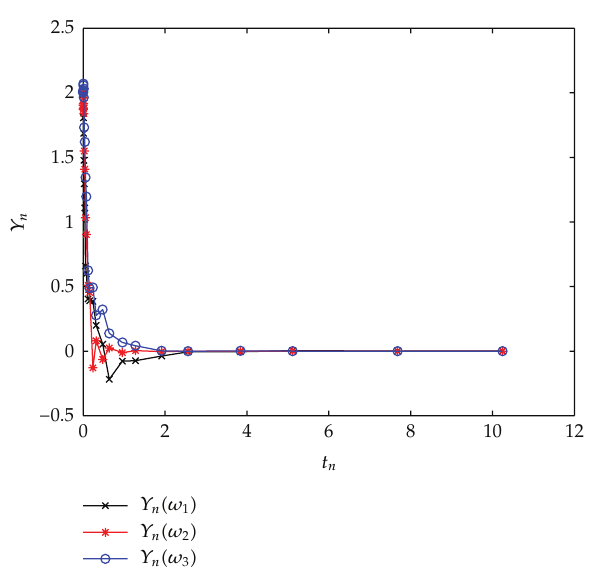
Figure 1: Almost surely asymptotic stability with x 0 (cid:7) 2 ,t 0 (cid:7) 0 . 01 , m (cid:7) 2.